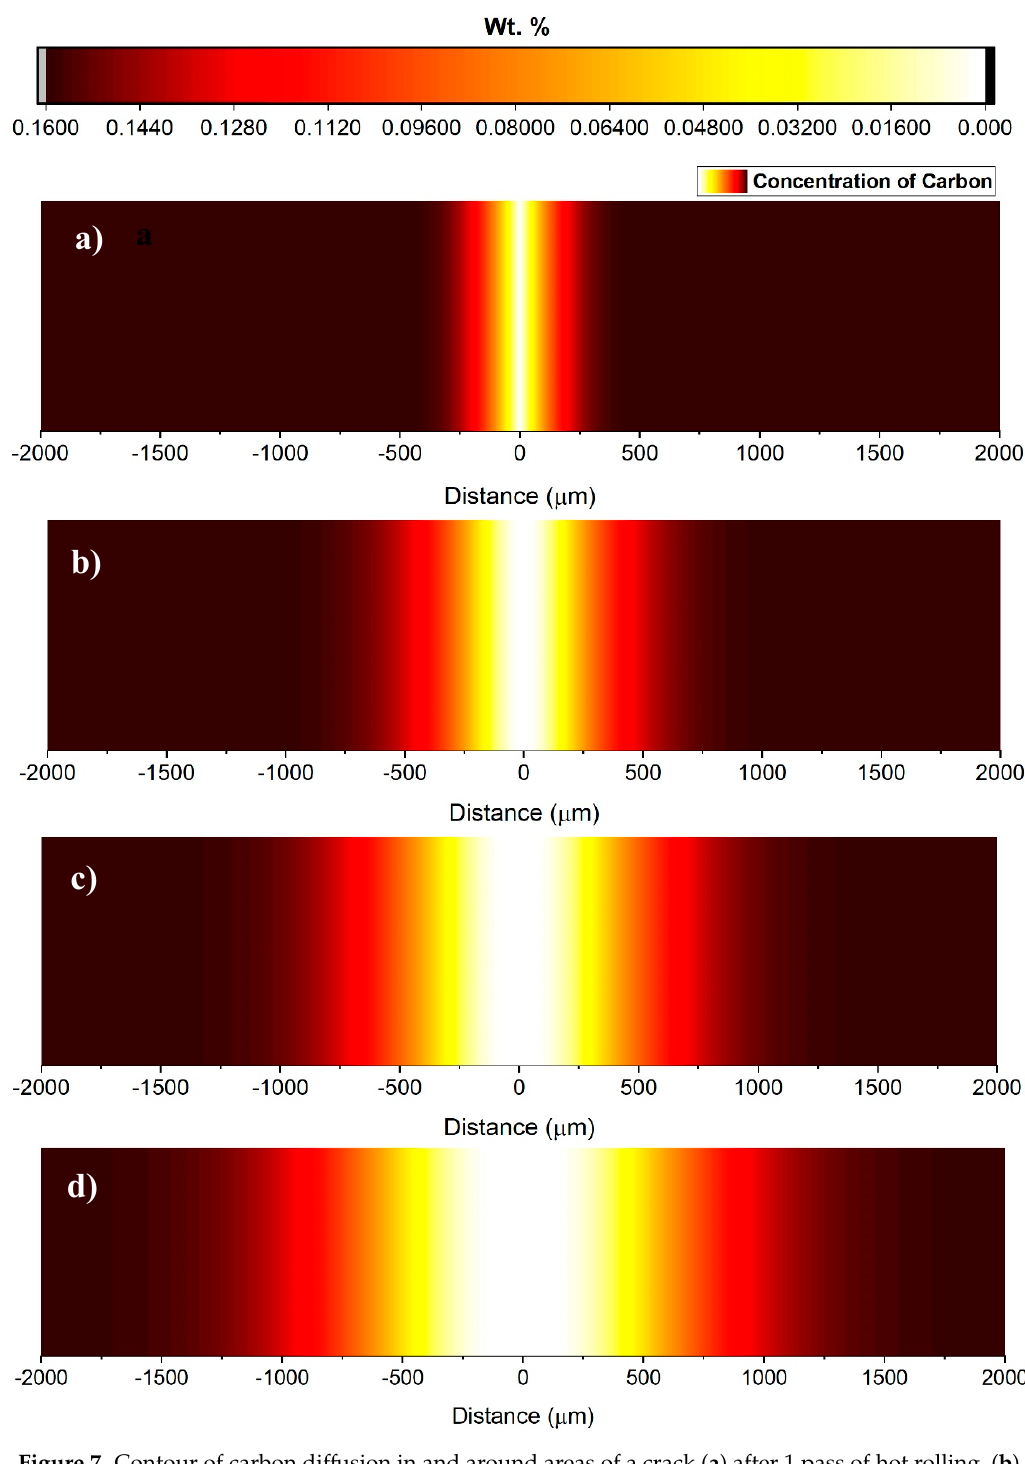
Figure 7. Contour of carbon diffusion in and around areas of a crack ( a ) after 1 pass of hot rolling, ( b ) after 5 passes, ( c ) after 10 passes, and ( d ) after 16 passes.